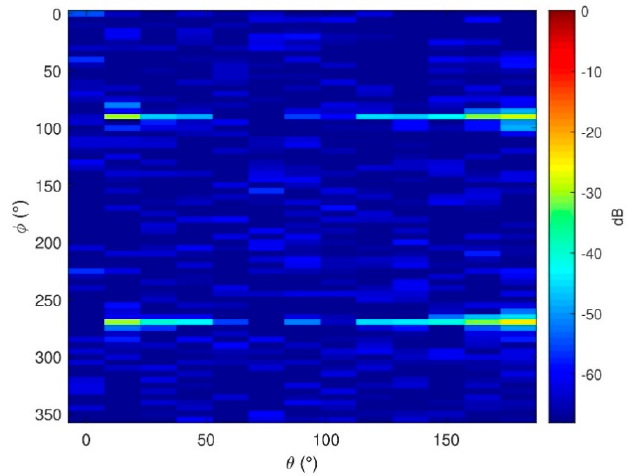
Figure 12. Electric NF error of E φ for the first subset after the initial phase retrieval.